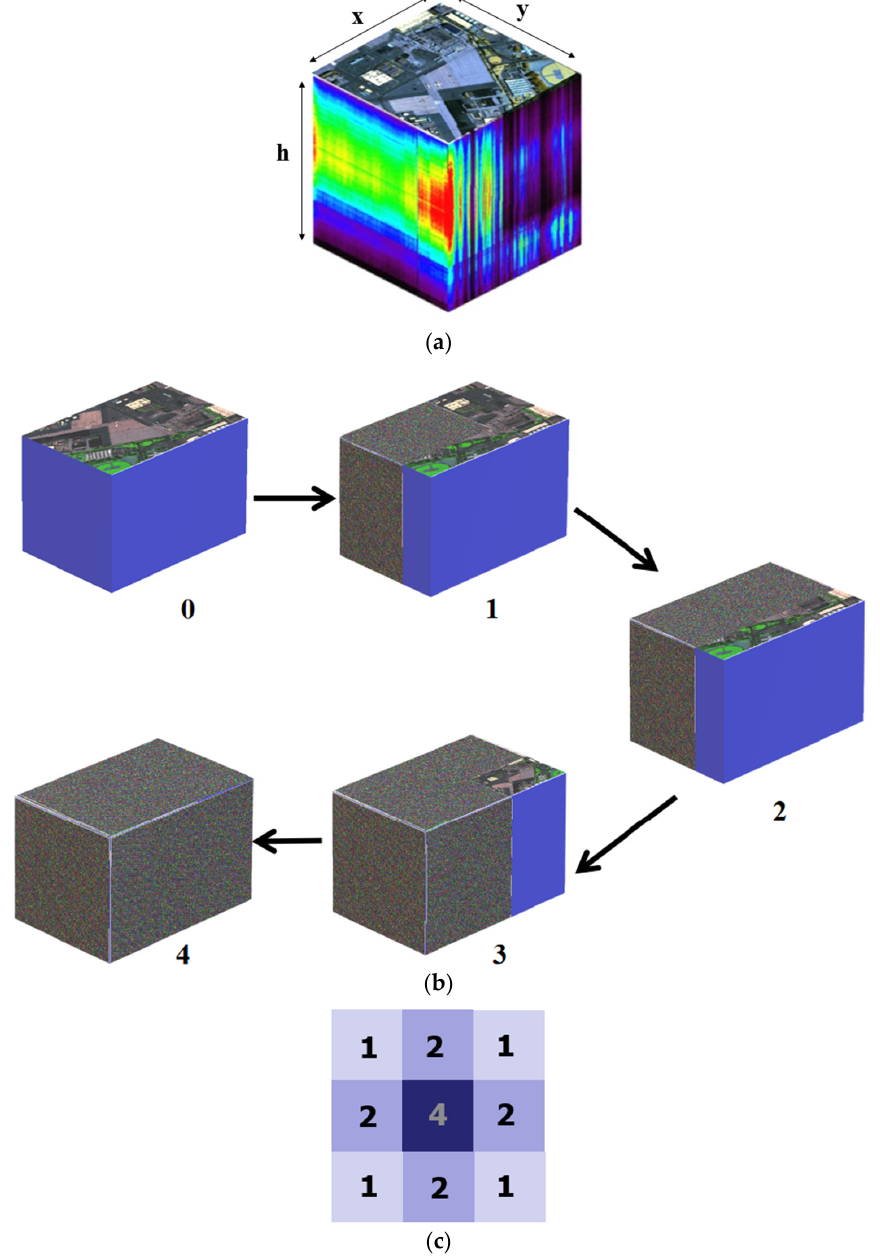
Figure 2. The block mobile method of 3D Arnold. ( a ) 3D model of hyperspectral image; ( b ) The movement schematic diagram of 3D Arnold transform; ( c ) The result of transformation and the number of transformations in different